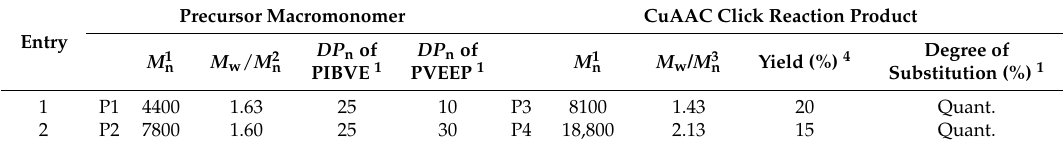
Table 1. Synthesis of MA-PIBVE- b -P(VE-Mal).